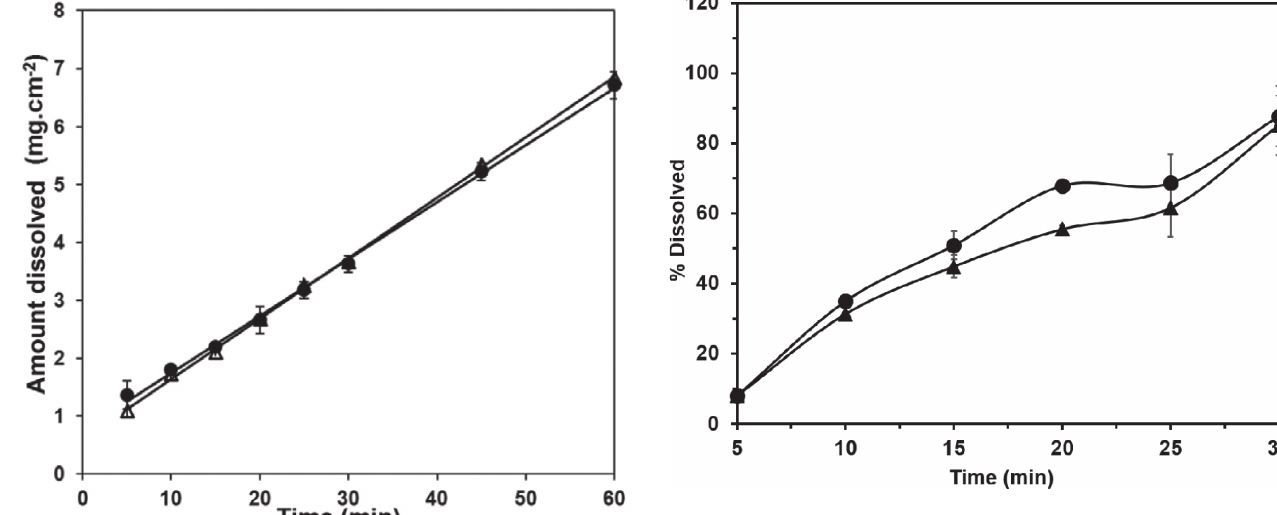
FIGURE 6 - Comparison between powder dissolution profiles of prednisone samples A (circle) and B (triangle).